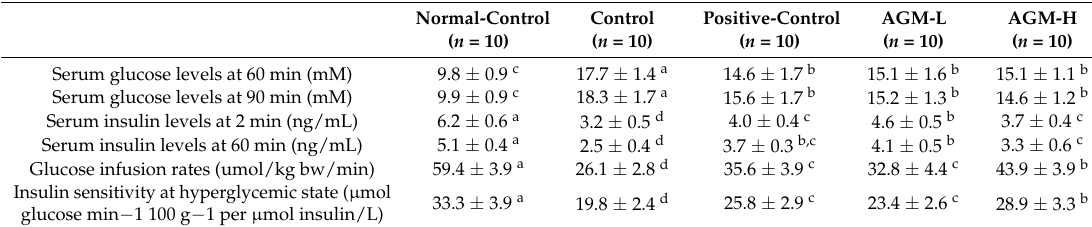
Table 4. Glucose metabolism during hyperglycemic clamp.